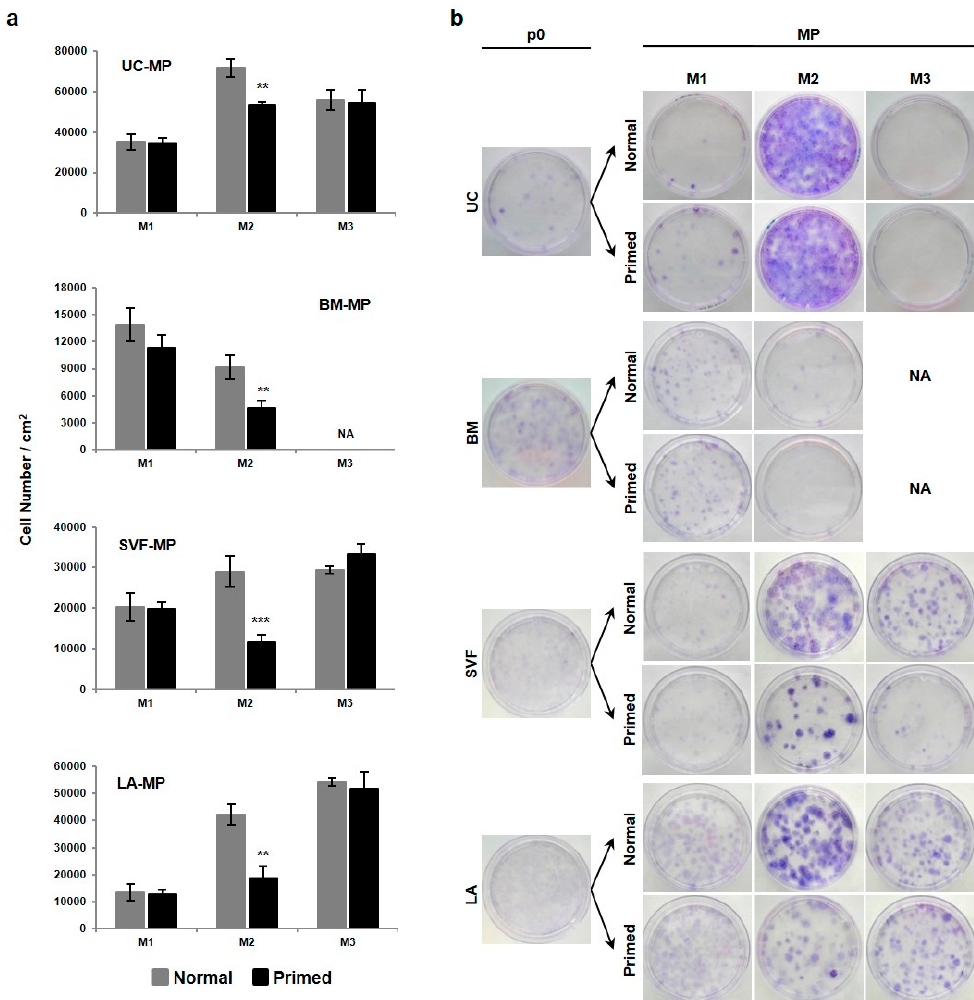
Figure 5. Proliferative properties of tissue-specific MSC-based MPs. ( a ) The yield of normal and primed cells expanded in M1, M2 and M3 media at the time of MP harvest. ( b ) CFU-F ability of normal and primed MPs seeded at the density of 50 cells per square centimeter. Giemsa staining shows variable progenitor number and potency. Results refer to the mean ± SD, n = 3. Statistics: unpaired t test (** p < 0.01, *** p < 0.001). NA—not available. Table 1. Expression of MSC markers and adhesion and HLA molecules in tissue-specific MSC-based MPs. Expression was determined in normal (N) and primed (P) MPs expanded in M1, M2 and M3 media. Results refer to the mean, n = 3. For MSC markers, underlined numbers indicate expression below 90 per cent; for adhesion and HLA molecules, * indicates expression increase in primed MPs compared to normal MPs (unpaired t test, p < 0.05). NA—not available. MSC Marker Expression (%)